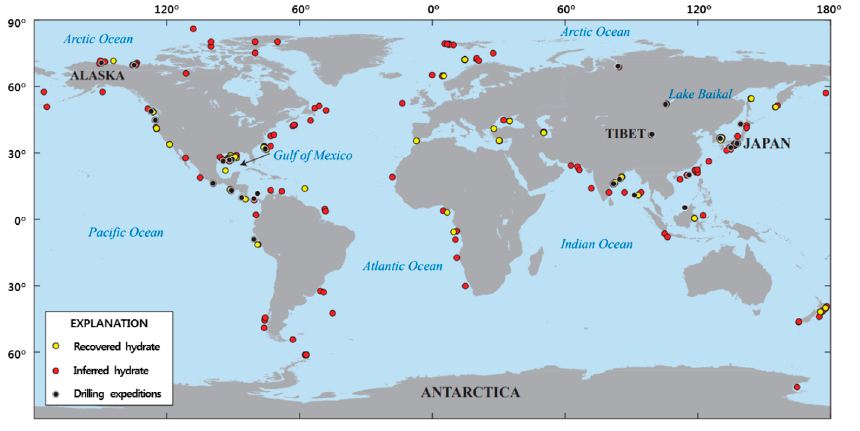
Figure 1. Distribution map of gas hydrate [4].